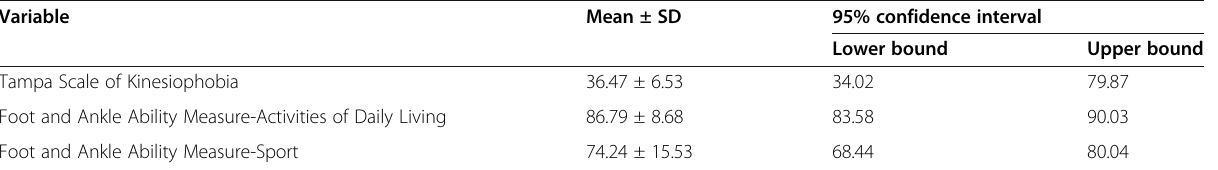
Table 2 Tampa Scale of Kinesiophobia, Foot and Ankle Ability Measure-Activities of Daily Living, and Foot and Ankle Ability Measure-Sport scores